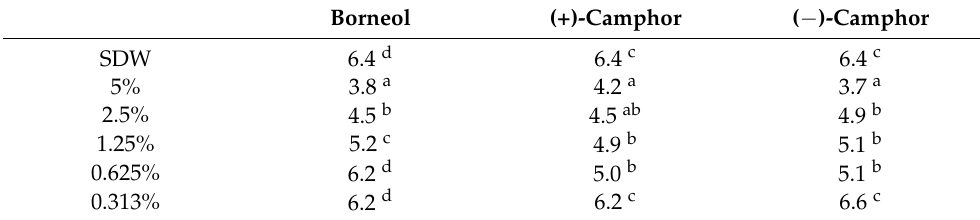
Table 3. Minimum inhibitory concentrations (MIC) of borneol, (+)-camphor and ( − )-camphor against A. alternata determined by the agar well-diffusion method. Data represent the means of 4 replicates of the diameter size (cm) of A. alternata